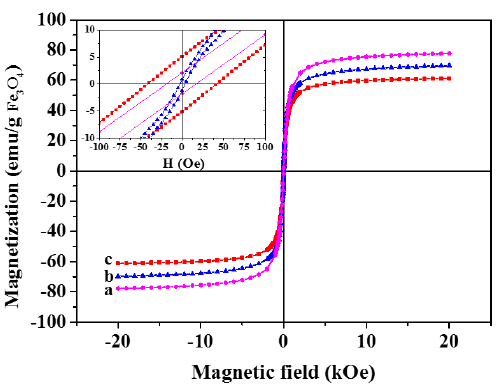
Figure 4. The magnetization curves of ( a ) IONPs; ( b ) GbMNP-2 and ( c ) GbMNP-3. Hysteresis loops at 27 °C up to ±20 kOe; the inset corresponds to the zoom in the low field region. Table 3. The magnetic properties of the uncoated IONPs and as-synthesized GbMNPs: saturation magnetization ( M s ), coercivity ( H c ), and saturation remanence ( M r ).